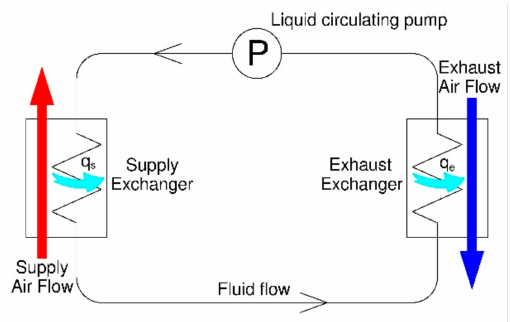
Figure 11. The scheme of ru-around heat exchanger.